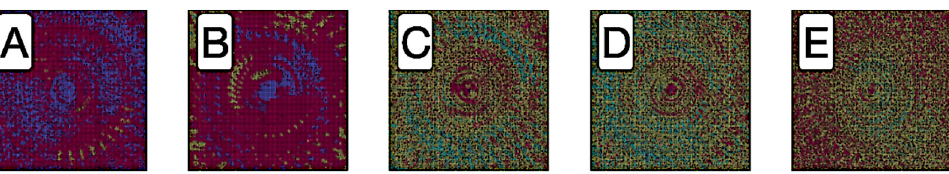
Figure 9. The variation-rotational pictures for the initial—( A ) and the modified—( B – E ) samples obtained from the SEM images of different magnification: 20 k—( A , B ); 15 k—( C ); 10 k—( D ); and 2.5 k—( E ).